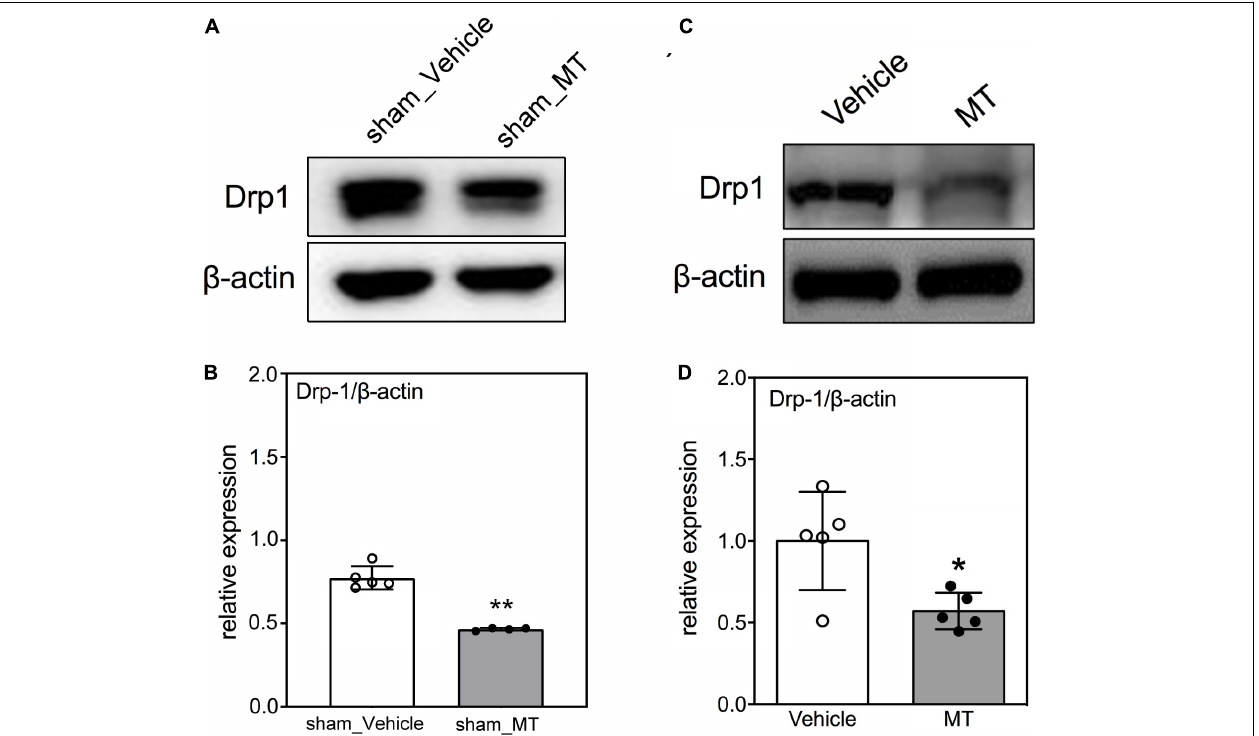
FIGURE 3 | Effects of mitochondrial transplantation on Drp1 expression in the injured spinal cord of rats with traumatic SCI on PID 1. (A) Representative micrograph of Western blot analysis of Drp1 in sham control groups. (B) Corresponding quantitative results of relative expression of Drp1 in sham control groups. (C) Representative micrograph of Western blot analysis of Drp1 in SCI groups on PID 1. (D) Corresponding quantitative results of relative expression of Drp1 in SCI groups on PID 1. The 1-cm spinal cord specimens centered at the epicenter of the injured site were used in Western blots. Data were expressed as mean ± standard deviation. * p < 0.05, ** p < 0.01, two-tailed Student’s t -test. N = 5. MT, mitochondria